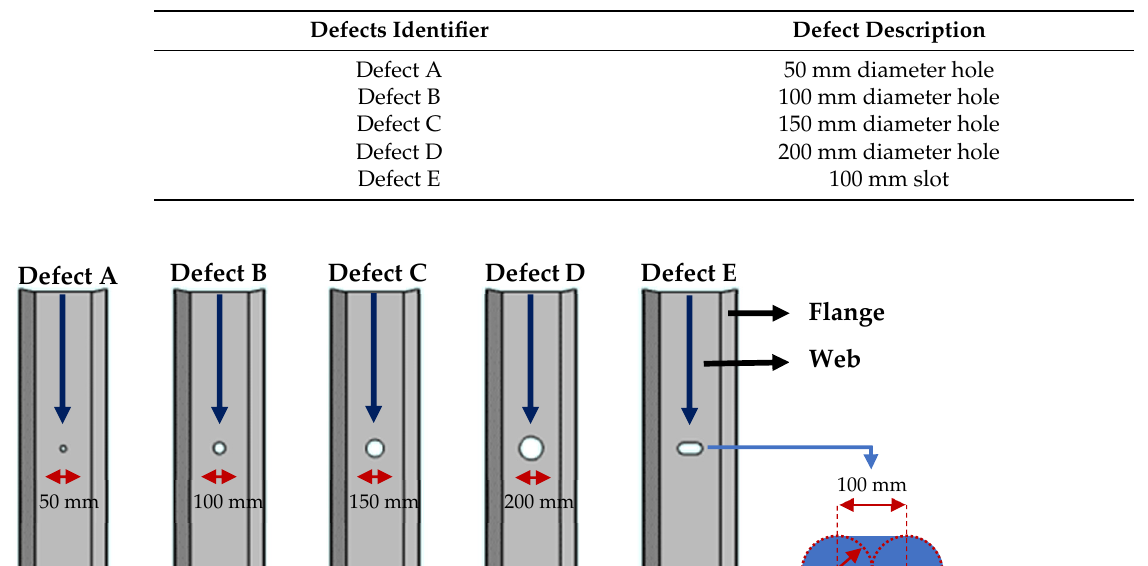
Table 2. Defect scenarios considered.